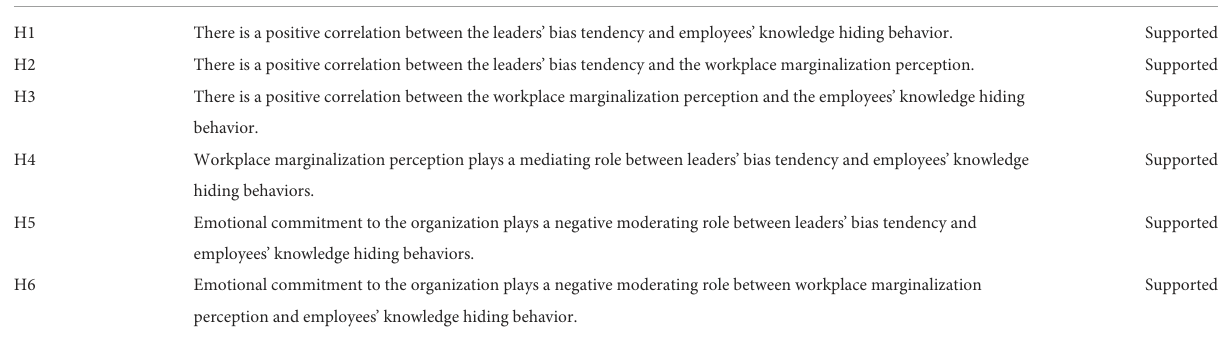
TABLE 6 The result of hypothesis